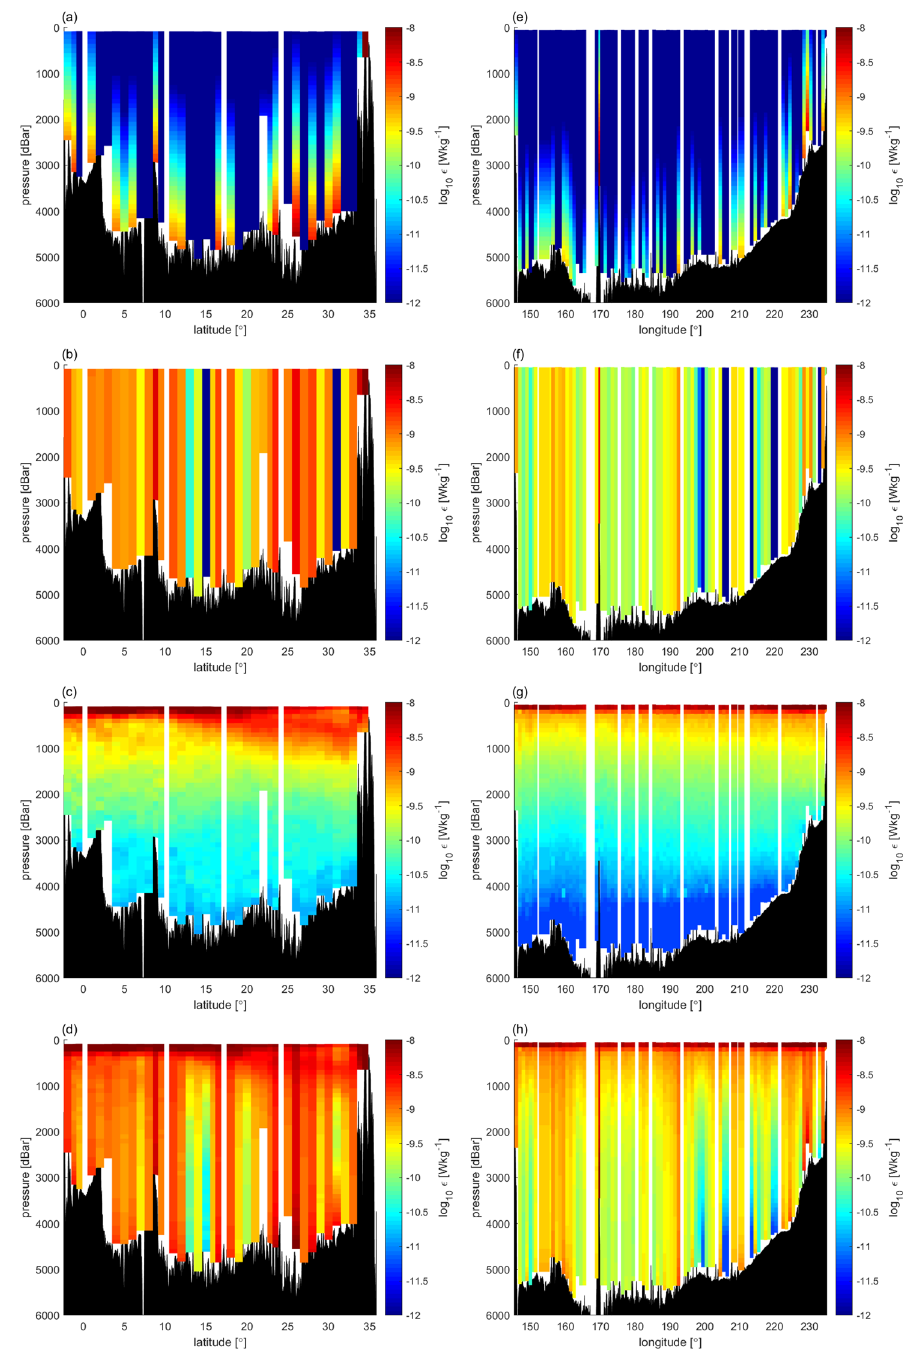
Figure 5. ε TideNF along 137°E (left) and 47°N (right). ( a , e ) Near-field, ε NEAR , ( b , f ) Far-field, ε FAR , ( c , g ) Background, ε BACK , ( d , h ) ε TideNF = ε NEAR + ε FAR + ε BACK . The squared buoyancy frequency is observation-based, and the mixing efficiency, Γ, is